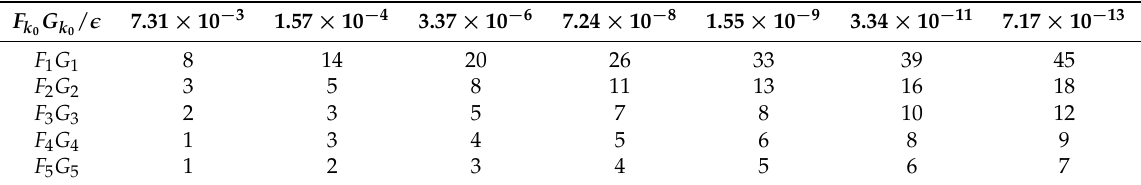
Table 10. Subdivision depth of 4-point ternary subdivision surfaces.